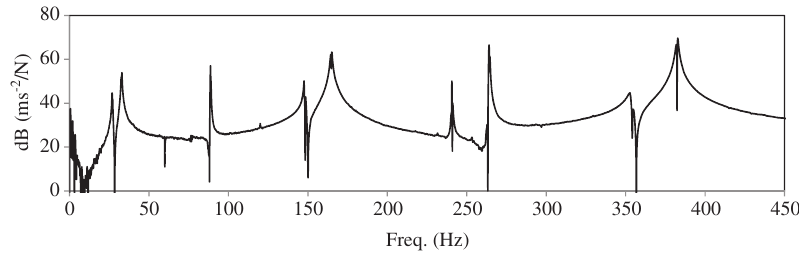
for truncated cone # 1. 21